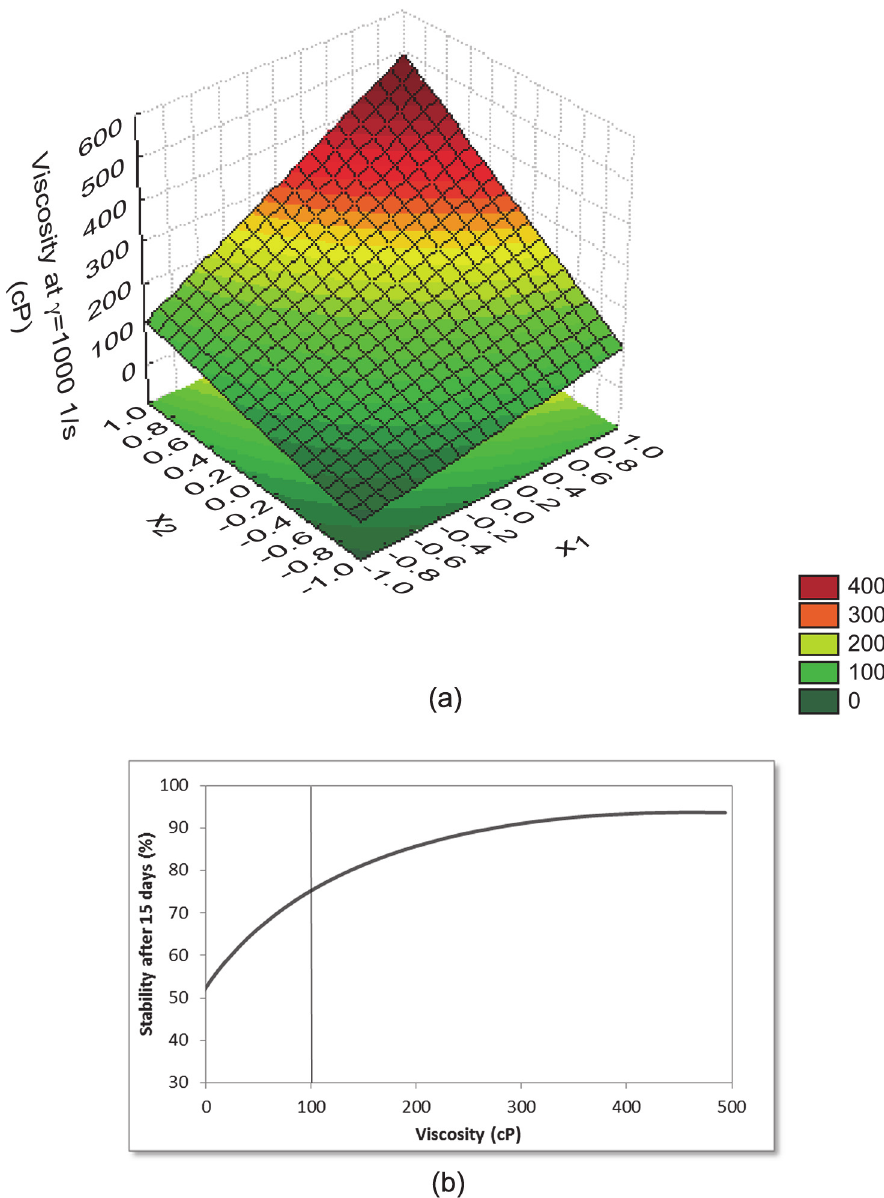
Fig 2. Results for viscosity of the emulsions at a shear rate of 1000 1/s (cP). (a) Response surface obtained from the model for cP (= 173 . 6 + 124 . 0 x 1 + 126 . 5 x 2 + 69 . 5 x 1 x 2 , where x 1 and x 2 are the normalized values of starch and Arabic gum concentrations). (b) Viscosity curve versus stability after 15 days. F = F = 6.94, indicating that the model can be considered significant. DF Reg, DF Res, α 2, 4, 0.05%